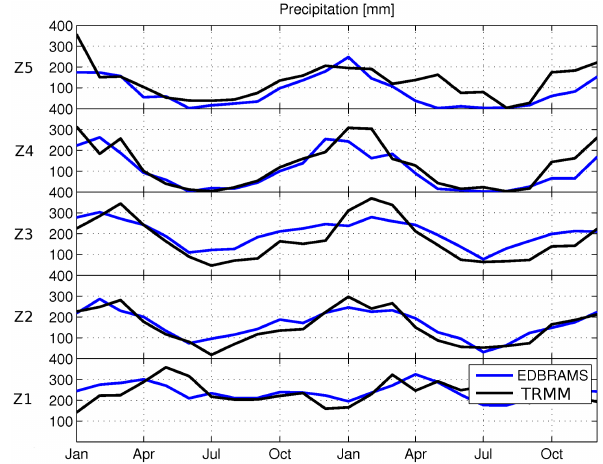
Figure D1. Mean monthly precipitation from ED2-BRAMS and the Tropical Rainfall Measurement Mission (TRMM) 3B43 product, years 2002–2003. Spatial means are taken within zones according to Fig. B2.